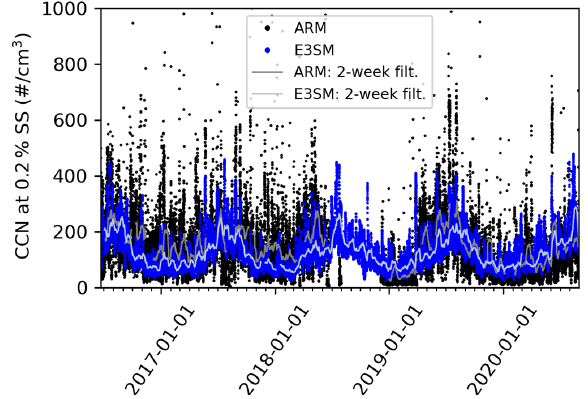
Figure 3. (a) Cloud condensation nuclei concentration at 0.2% su- persaturation are measured from ARM (black) and simulated using E3SM (blue) at the ENA site over the period 21 June 2016–29 Au- gust 2020. A 2-week filter is applied to the hourly data for ARM (gray) and E3SM (light blue) data